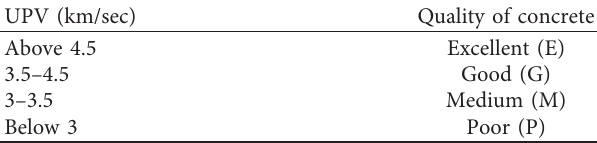
Table 6: Grading of concrete using pulse velocity [8].